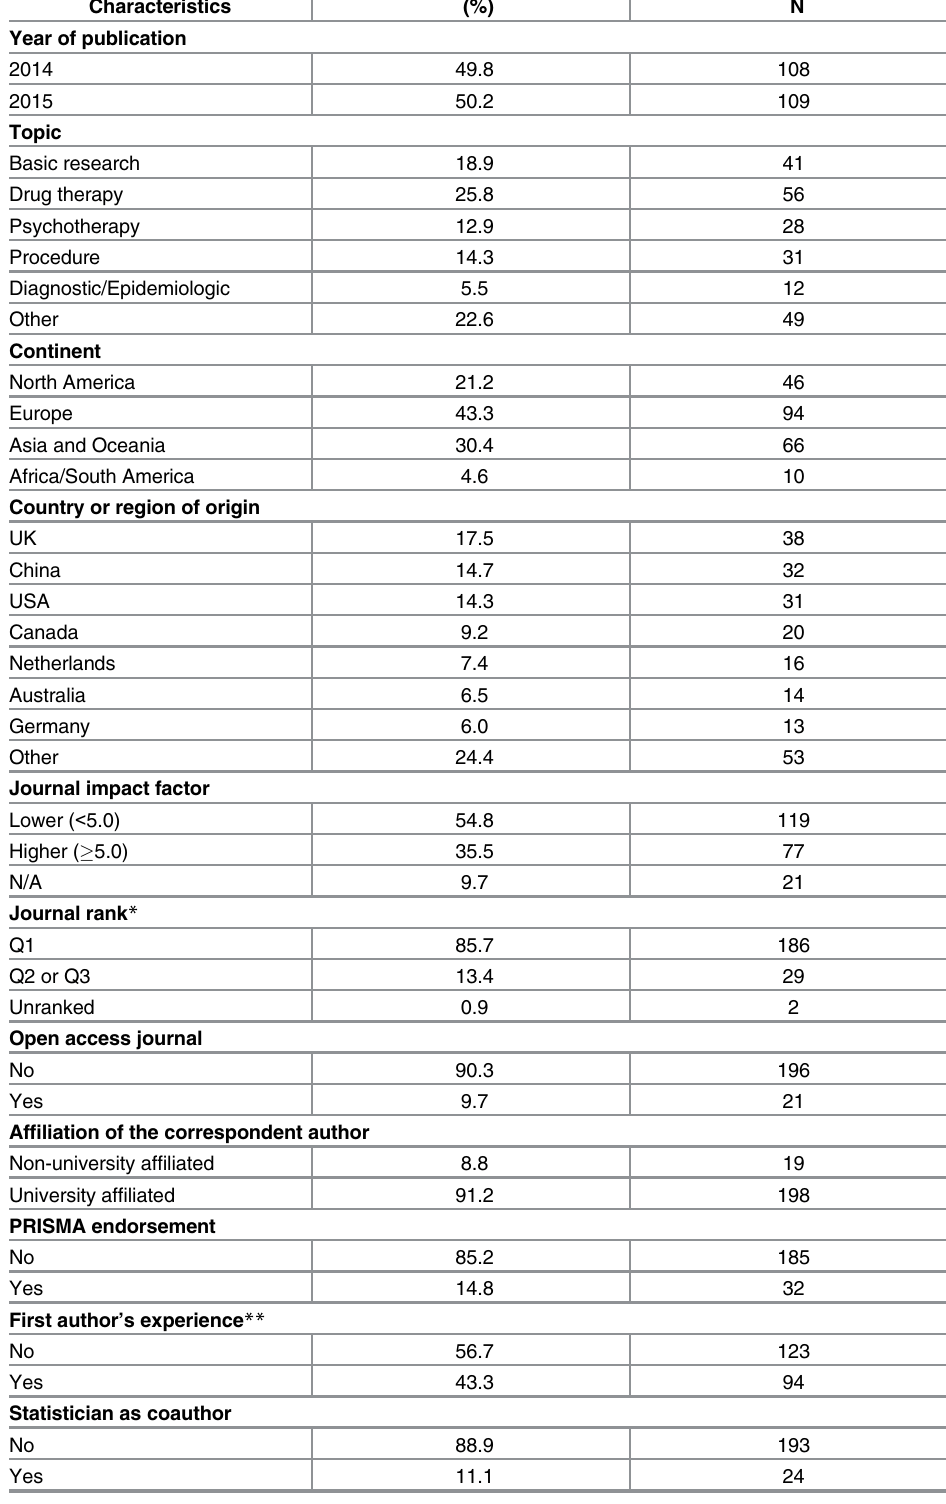
Table 1. Characteristics of included